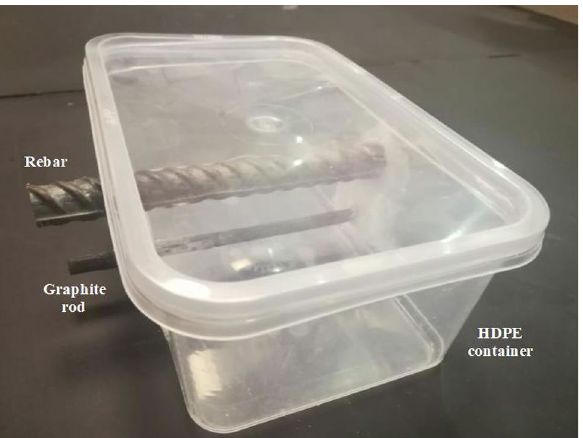
Figure 2. Photograph of the cell used to expose the rebars test samples in simulated pore solutions to conduct the electrochemical